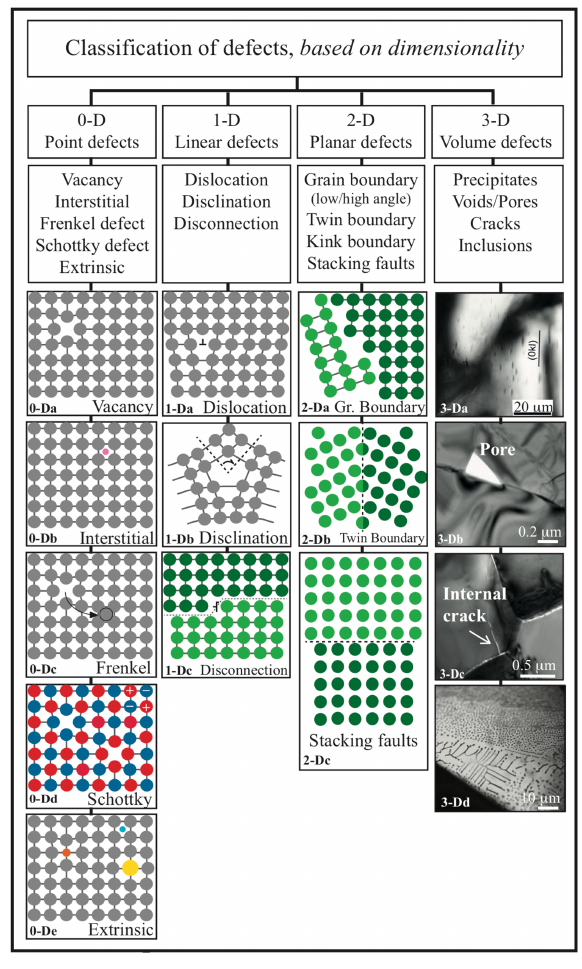
Figure 3. Classification of defects in crystals based on dimen- sionality. From 3-Da to 3-Dd, examples are provided specifically for olivine: 3-Dc, internal crack and open grain boundaries in nanoforsterite (from Gasc et al., 2019); 3-Da, Ti-rich precipitates in Ti-doped forsterite (from Padrón-Navarta et al., 2014); 3-Db, a pore in He-doped San Carlos olivine (from Burnard et al., 2015); 3-Dc, internal crack in nanoforsterite from Gasc et al. (2019); and 3-Dd, supercritical CO 2 inclusions in San Carlos olivine (unpub- lished image of sample SC32-1 from Demouchy,